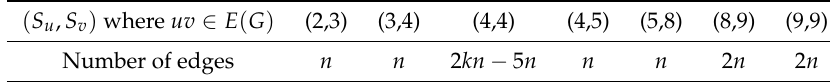
Table 5. The edge partition of the graph G for k >